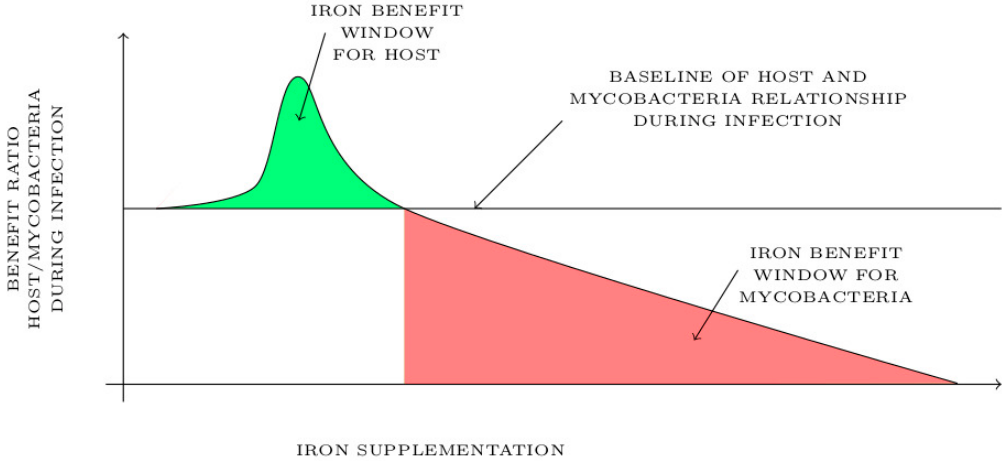
Figure 7. Suggested model of biphasic effect of iron supplementation during mycobacterial infection. A moderate concentration of iron supplementation can have a benefit effect for host during mycobacterial infection (shown in green). However, at high concentration of iron supplementation, iron can be beneficial for mycobacteria promoting growth and virulence (shown in red).